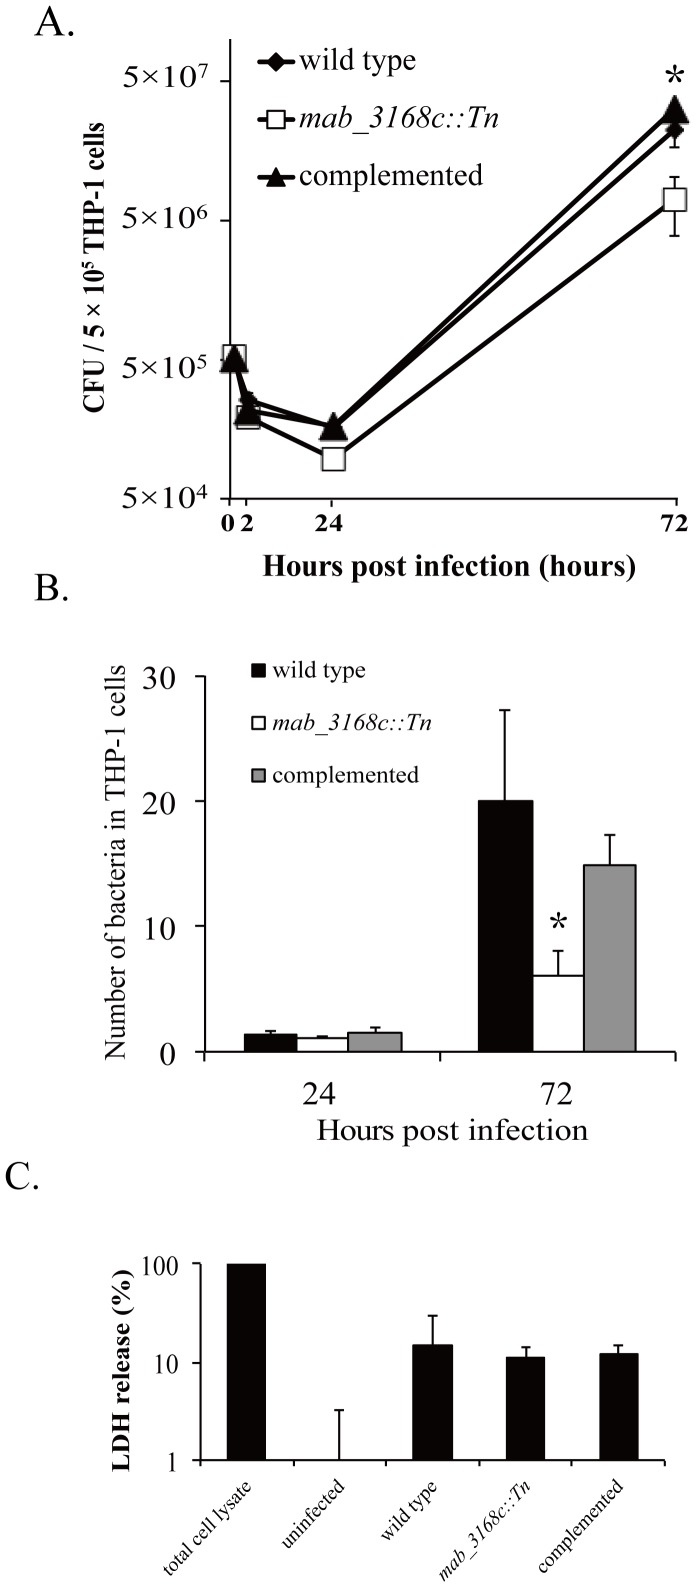
Intracellular survival of M. abscessus cells.(A) THP-1 macrophages were co-cultured with wild type, mab_3168c::Tn, or complemented M. abscessus cells at an MOI of 1 for 2 hours at 37°C. Mycobacterial CFUs in THP-1 cell lysates were then determined at the indicated time points. (B) The number of intracellular M. abscessus variants was determined by confocal microscopy. At the indicated time, the M. abscessus-infected THP-1 macrophages were fixed and permeabilized prior to staining the intracellular mycobacteria with auramine-O. Organisms in at least 100 cells per slide were counted. (C) Viability of M. abscessus-infected THP-1 macrophages. THP-1 macrophages were infected with wild type, mab_3168c::Tn mutant, and complemented mutant for 72 hours. The levels of LDH activity in the culture supernatants were measured. Results shown are means ± standard deviations of three independent experiments. Data were analyzed by one-way ANOVA and Fisher’s PLSD test. The asterisk sign (*) represents p<0.05 of mab_3168c::Tn versus wild type or mab_3168c::Tn versus complemented strain.